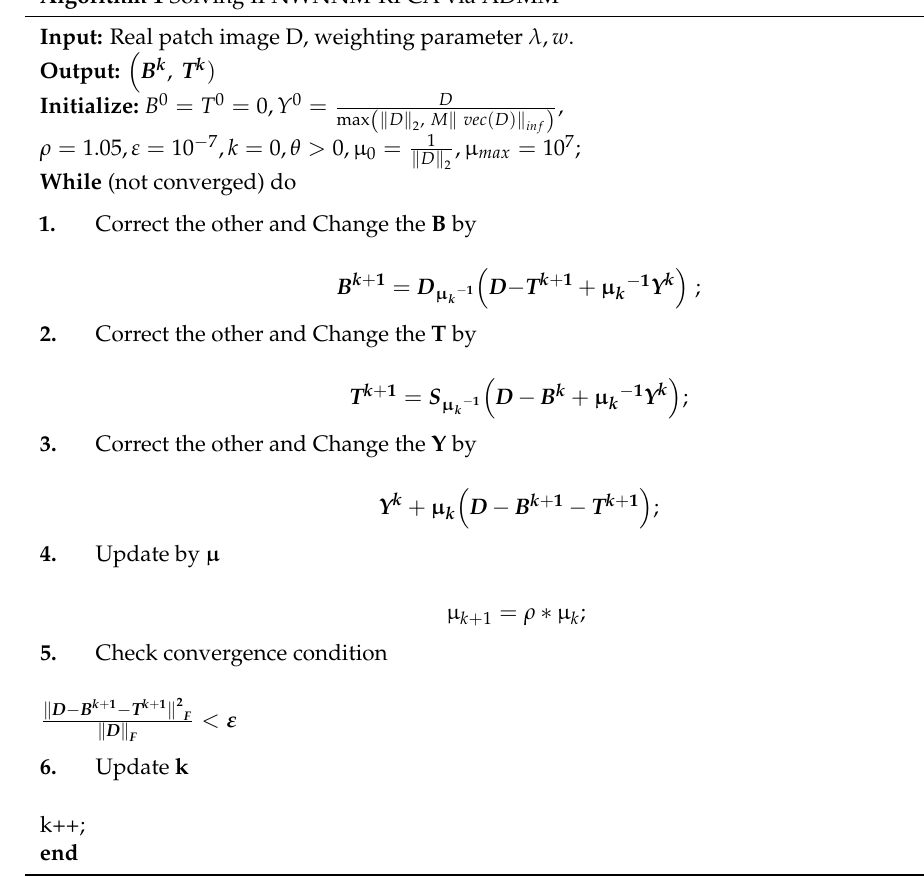
Algorithm 1 Solving IPNWNNM-RPCA via ADMM